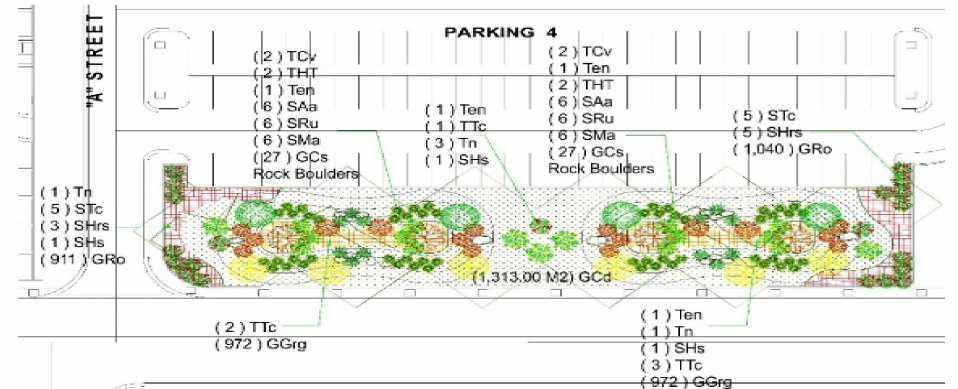
Figure 7. The previous situation for Parking 4 landscape area. Previous tender softscape design (Details of water consumption is shown in Table A2).